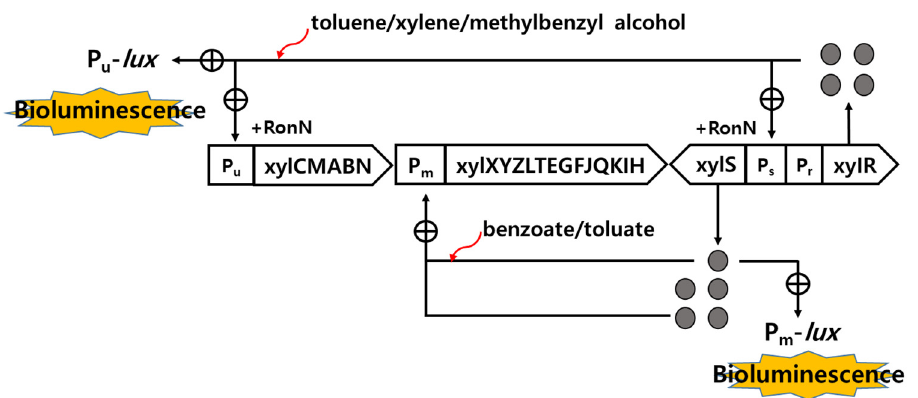
Figure 1. Regulation of recombinant P u -lux and P m -lux genes ( ⊕ : positive control; ● : regulatory protein) (modified from [9]).